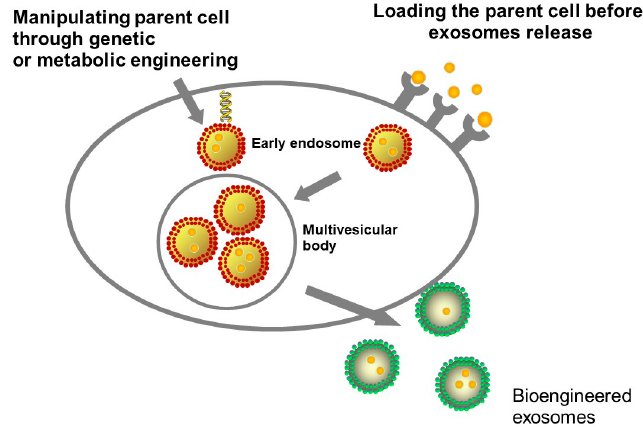
Figure 2. Loading strategies may rely on pre-loading parental cells with the cargo of interest before inducing extracellular vesicles (EVs) release or manipulating parent cell through genetic or metabolic engineering. Cancers 2020 , 12 , x